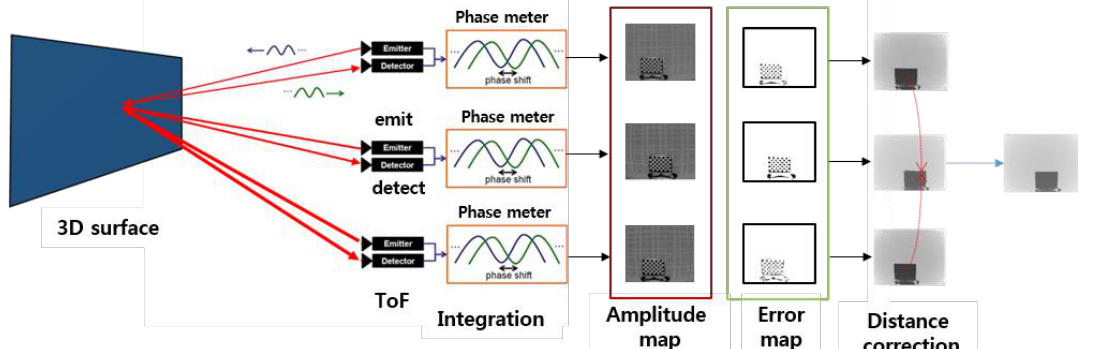
Figure 9. Operation of the proposed distance error correction method.